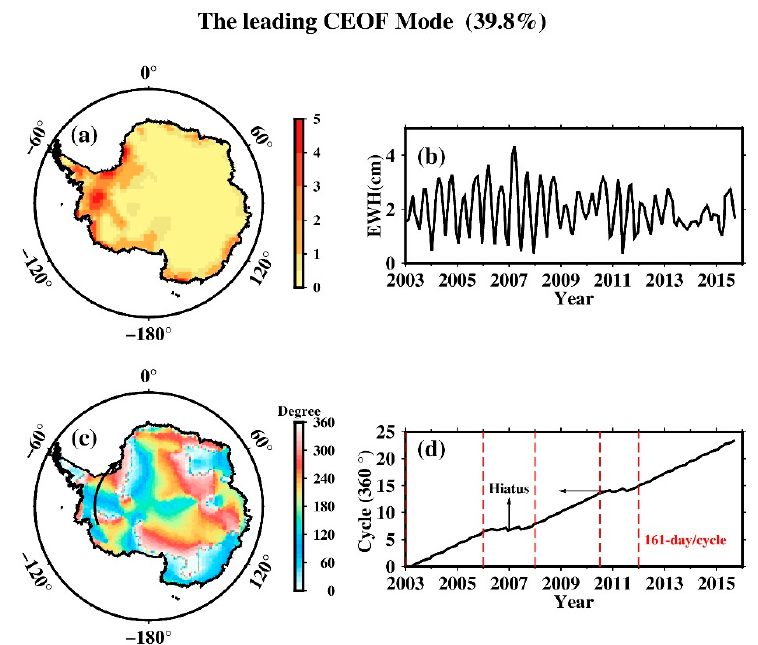
Figure 6. The leading CEOF mode of the non-seasonal mass variation over Antarctica from GRACE data (after removal of the EOF Mode 1 or ACD). For amplitude: ( a ) root-mean-square amplitude map; ( b ) corresponding strength variation. For phase: ( c ) spatial phase map in degree (largely clockwise spin or eastward propagation); ( d ) unwrapped temporal phase.